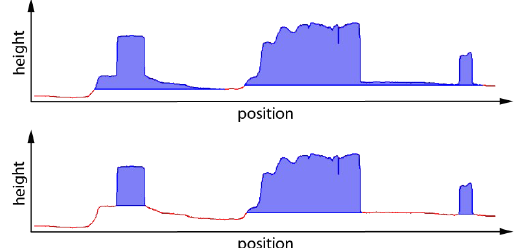
Figure 4. The effect of the negative 1 term. Above: the elevated objects found without the term. Below: the solution found when greedy .